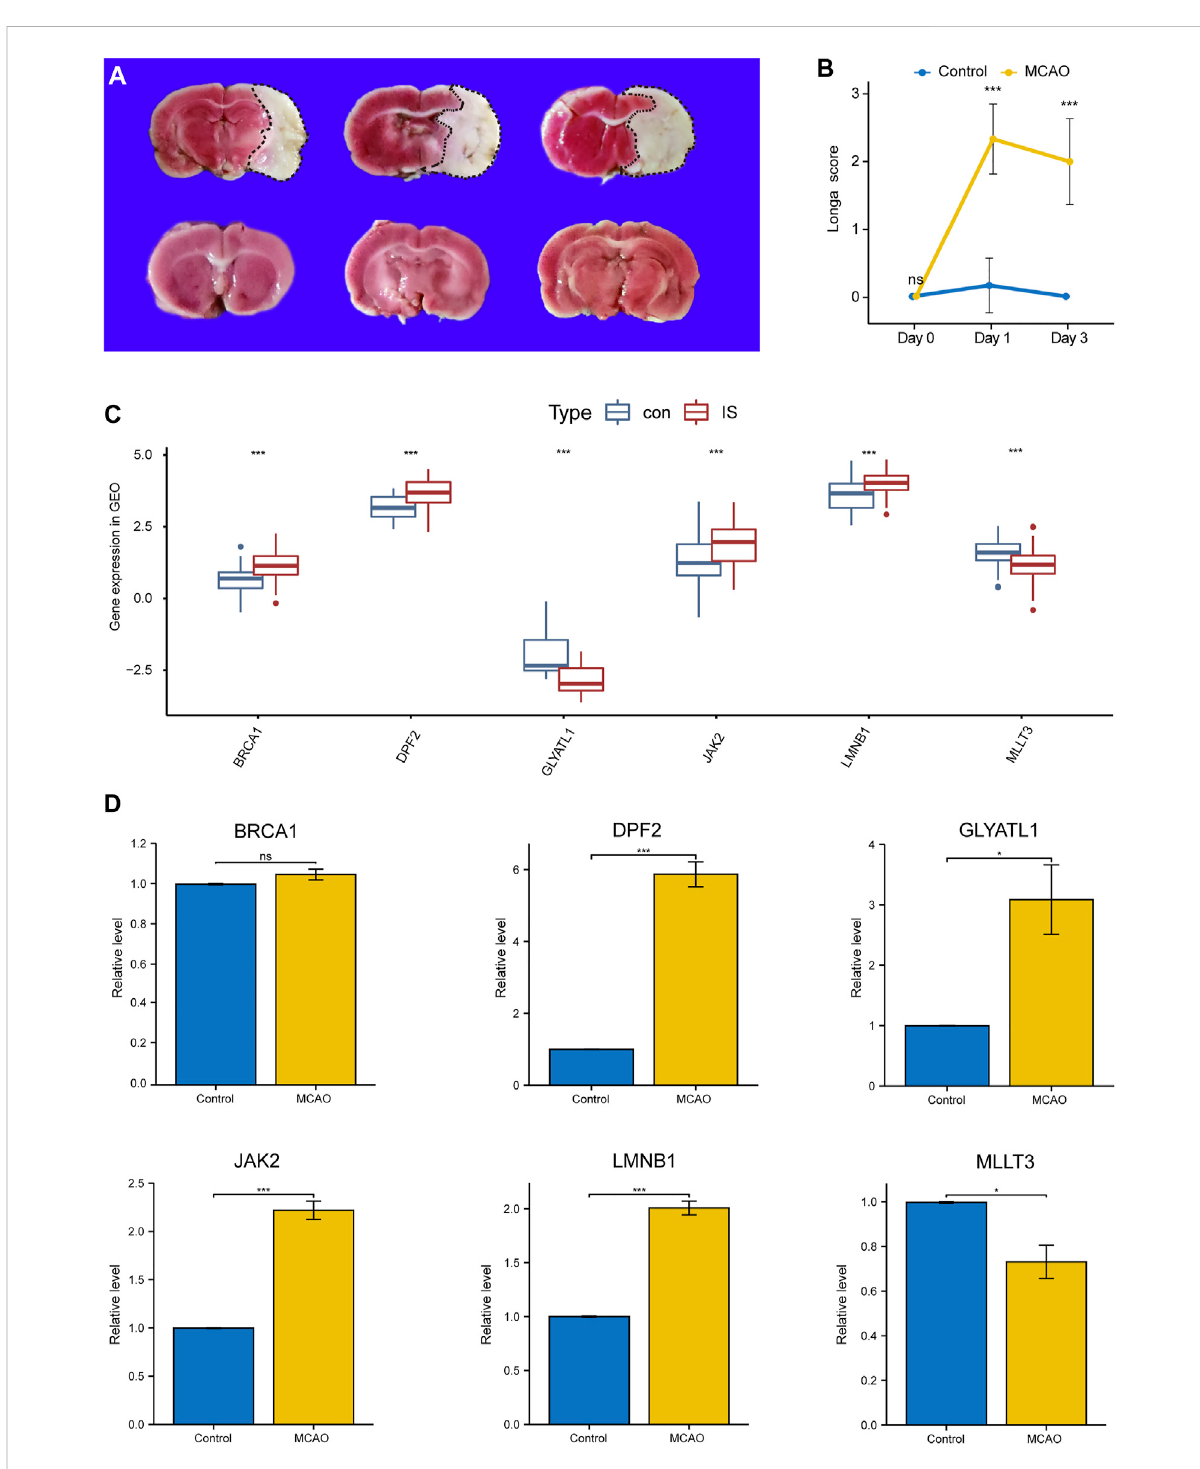
FIGURE 5 Validation of Key Immune biomarkers by MCAO models. (A) TTC staining in Sham group and IS group. (B) Longa scores in Sham group and IS group. (C) Expression of CRs-related immune biomarkers in GSE58294 and GSE22255 datasets. (D) qPCR veri fi es the expression of CRs-related immune